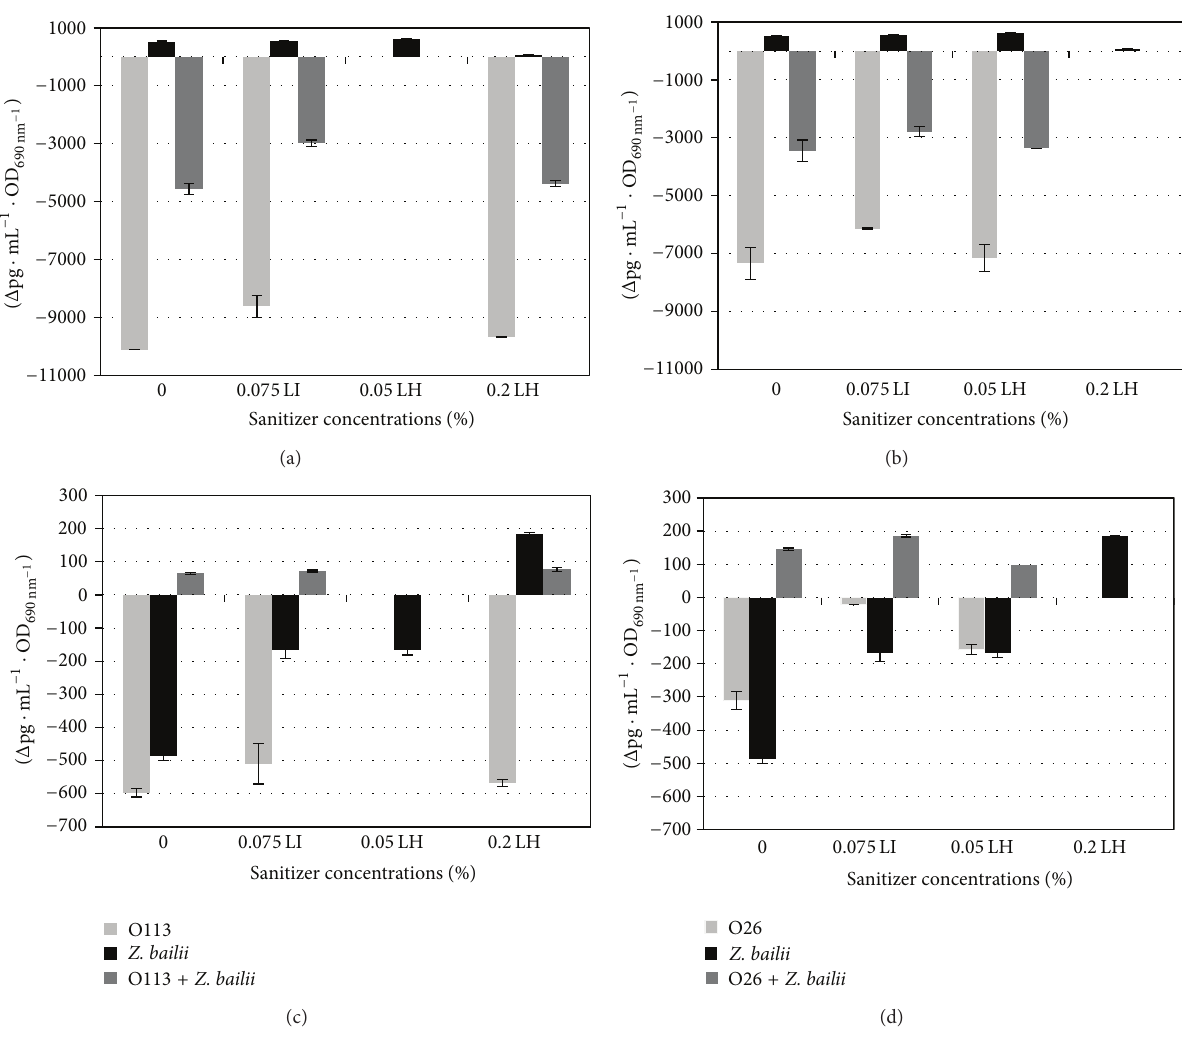
Figure 1: Changes in EPS/LPS toxicity of pure and mixed cultures of E. coli and Z. bailii following exposure to different concentrations of liquid iodophor and liquid